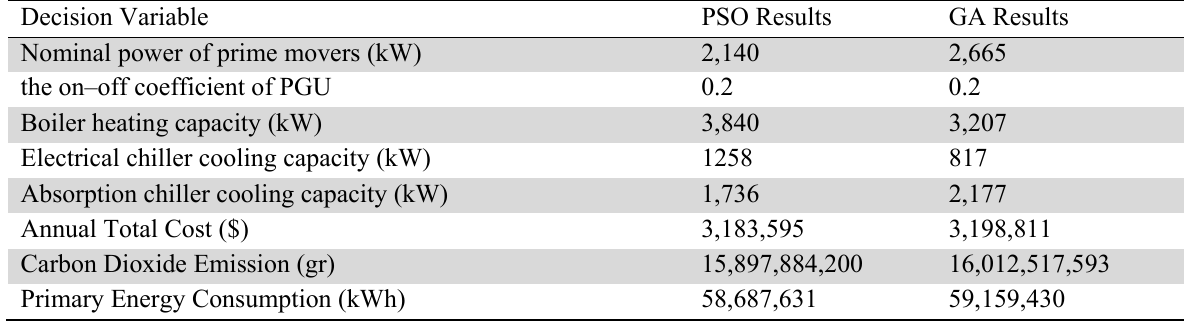
Best design of the system at FTL strategy